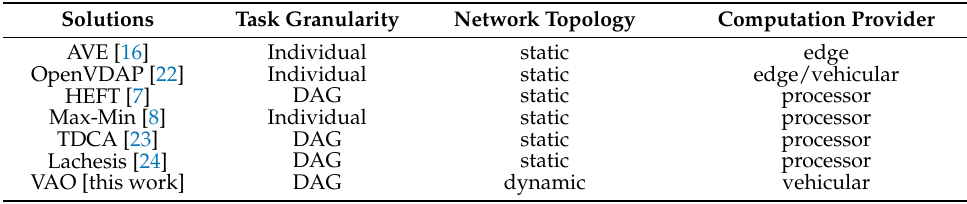
Table 1. Comparison of Related